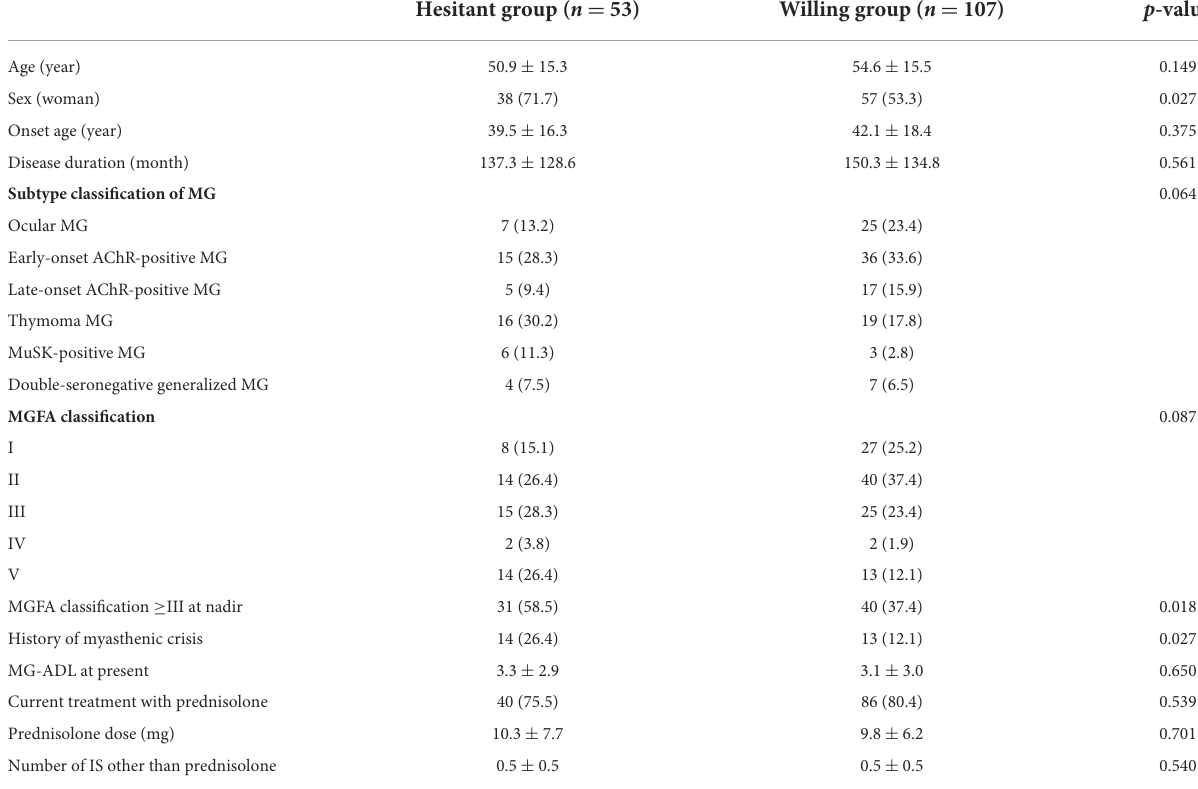
TABLE 2 Comparison of clinical characteristics between willing and hesitant